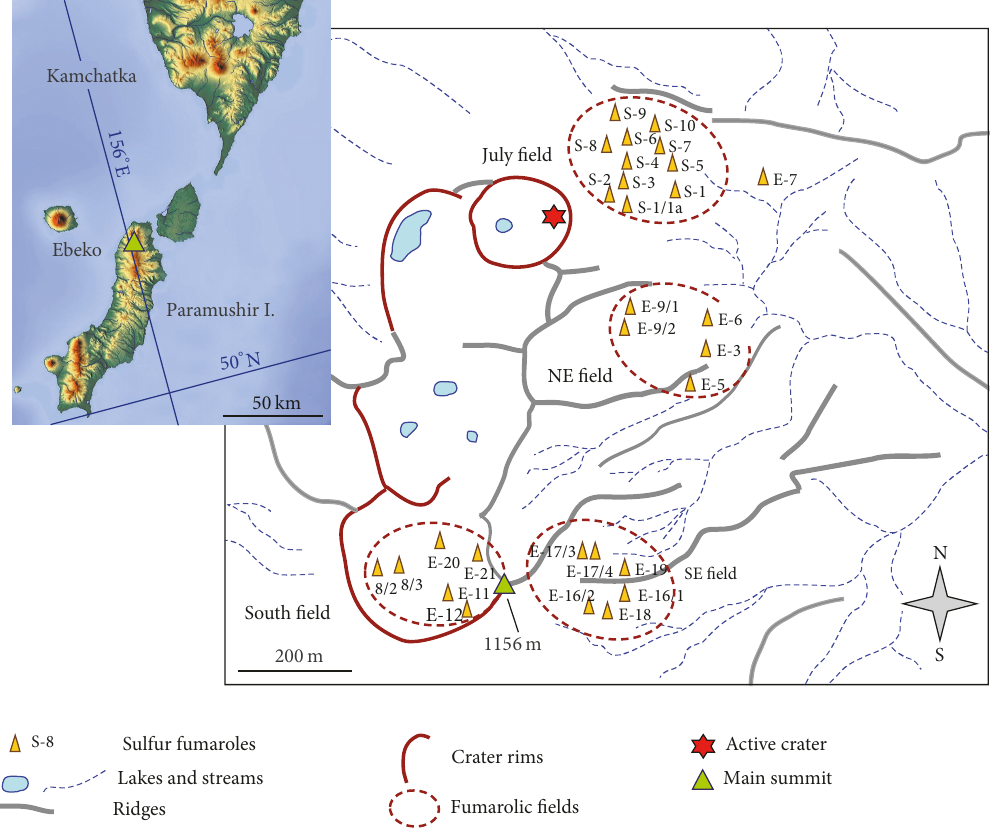
Figure 1: Location of Ebeko volcano and a sampling scheme with fumarolic fields.